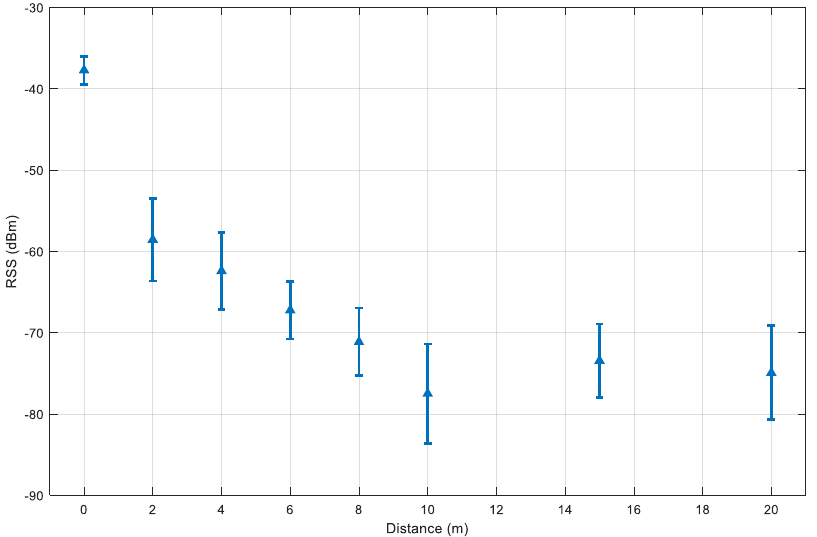
Figure 8. The mean RSS and its standard deviation values for selected distances between two smartphones.